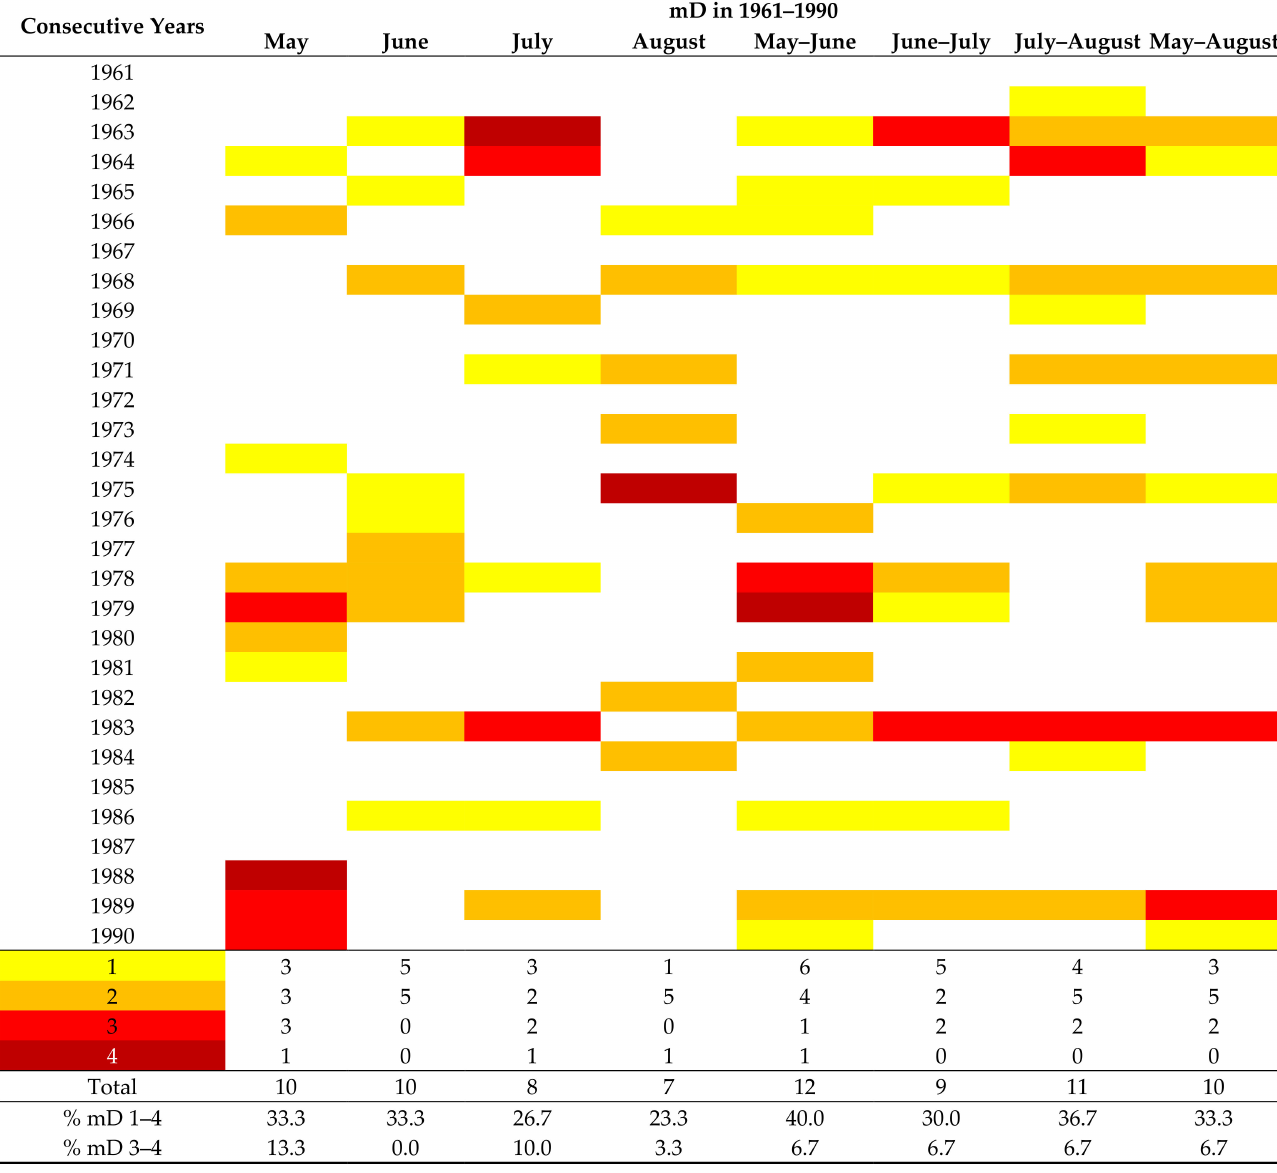
Figure 1. Occurrence of meteorological droughts (mD) determined on the base of the SPI during the period of active plant growth and development (May–August) in the region of Bydgoszcz in 1961–1990. The colors illustrate the level of drought